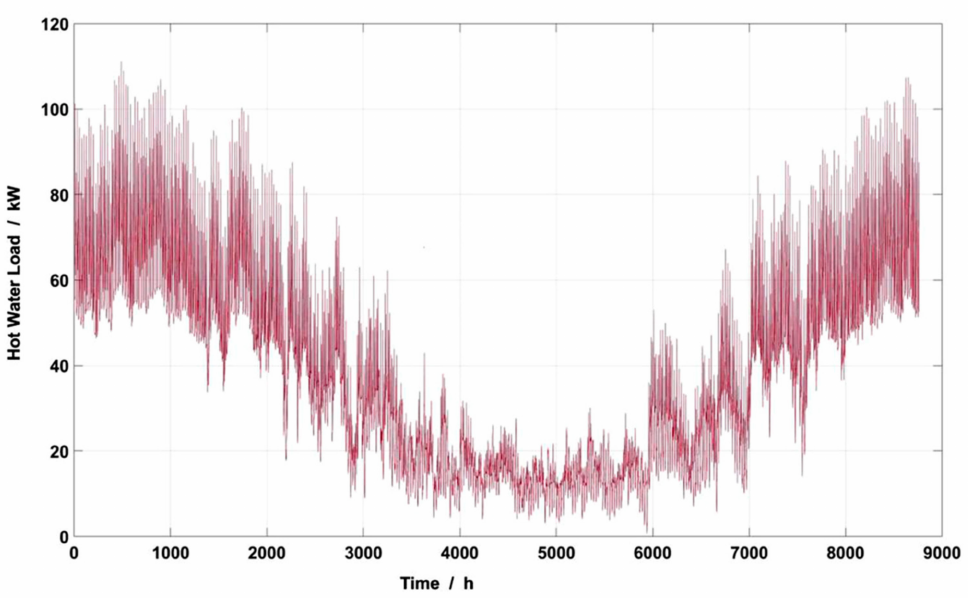
Figure 9. Annual hourly hot water